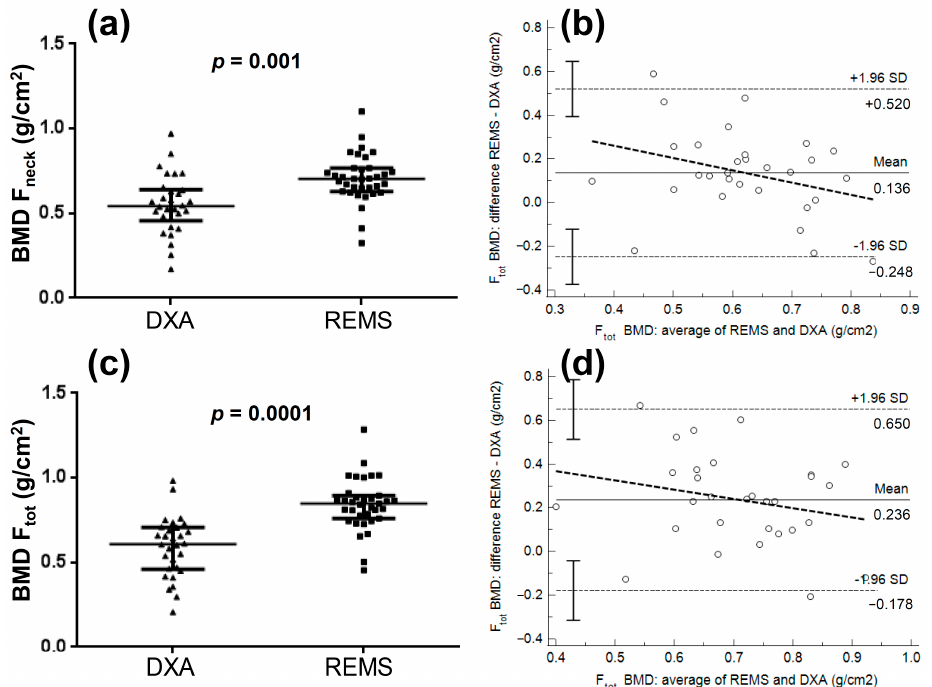
Figure 3. Comparisons of femoral neck bone mineral density (BMD F neck : panel ( a )) and total femur bone mineral density (BMD F tot : panel ( c )) between DXA and REMS and relative Bland-Altman plots (panels ( b – d )) in patients with disuse-related osteoporosis.